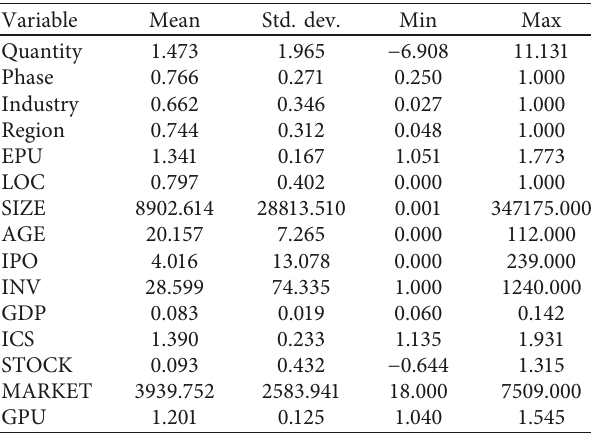
Figure 1: EPU and the quantity of venture capital investment in China. Table 2: Descriptive statistics for each